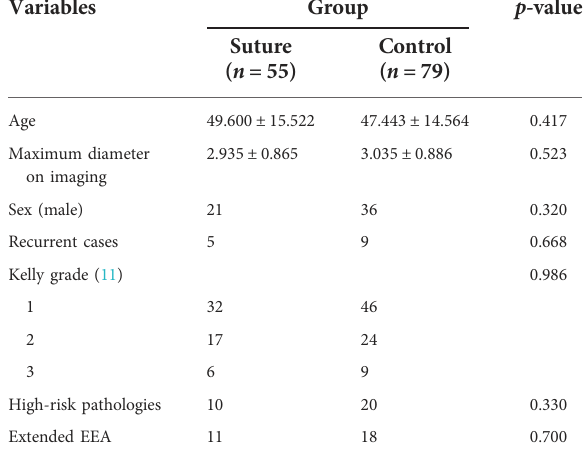
TABLE 1 General